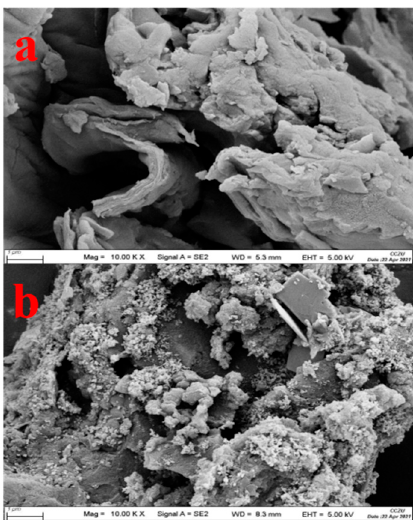
Figure 1. SEM image of CSW ( a ) and CSUTS-CSW ( b ).